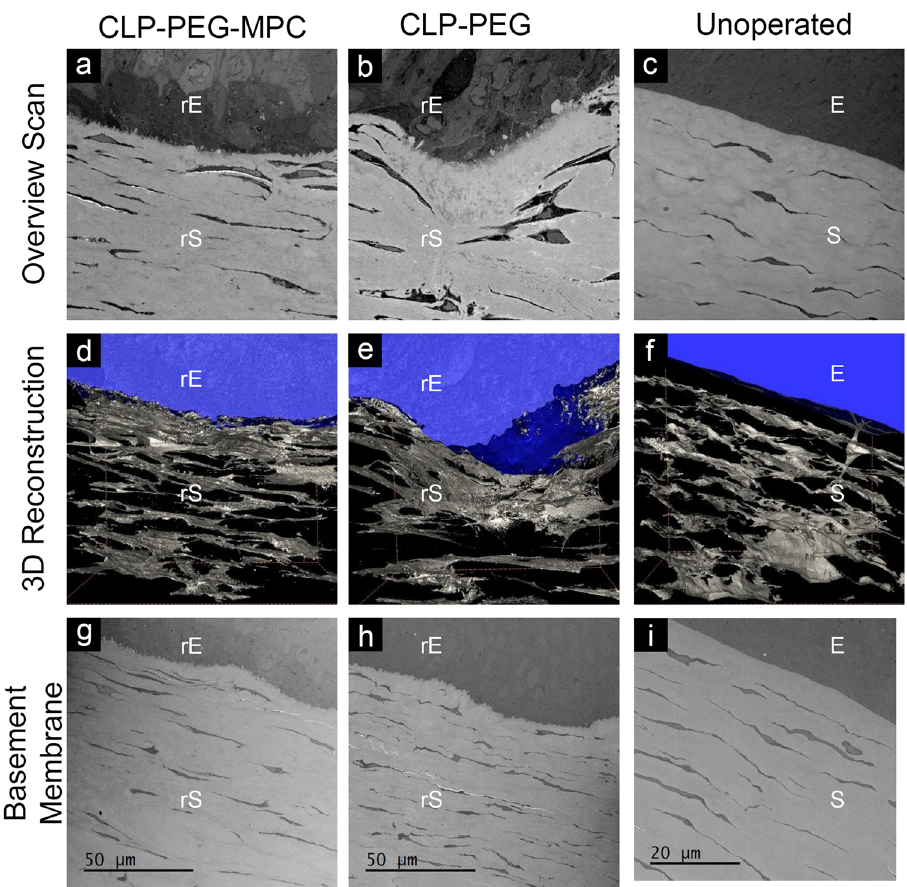
Fig. 7 Electron micrographs of regenerated neo-corneas after CLP-PEG and CLP-PEG-MPC implantation. Serial block face scanning electron microscope overview scans show comparable epithelial and stromal compartments ( a – c ). 3D reconstructions ( d – f ) of the neo-corneas after digital removal of the extracellular matrix show that keratocytes within the stroma are arranged in interconnected lamellae. The lamellae in the CLP-PEG only implanted corneas are less organized than in the other two groups. g – i Transmission electron microscopy of the corneas indicates that both operated groups ( g , h ) have invaginated basal epithelia. E, epithelium; S, stroma; r,